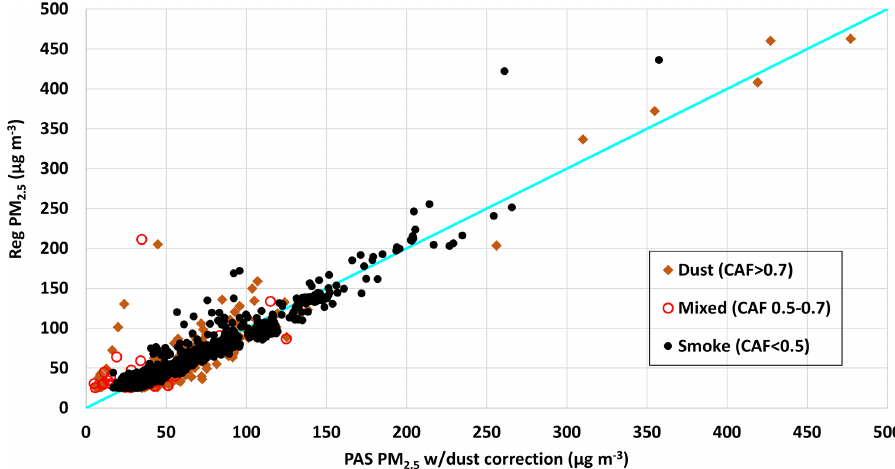
Figure 6. Regulatory PM 2 . 5 versus PAS PM 2 . 5 with the dust correction (Eq. 4) at Keeler, CA, for hours with regulatory PM 2 . 5 of > 25µgm − 3 . The data are separated by the coarse aerosol fraction (CAF), as measured by the regulatory data. The light blue line shows a 1:1